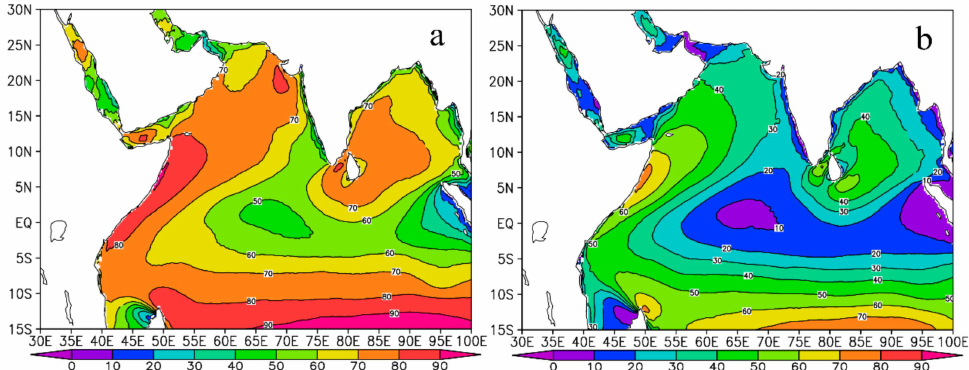
Figure 7. Occurrence of annual average wind energy density larger than 50 W / m 2 (unit: %) ( a ) and larger than 200 W / m 2 (unit: %) ( b ).